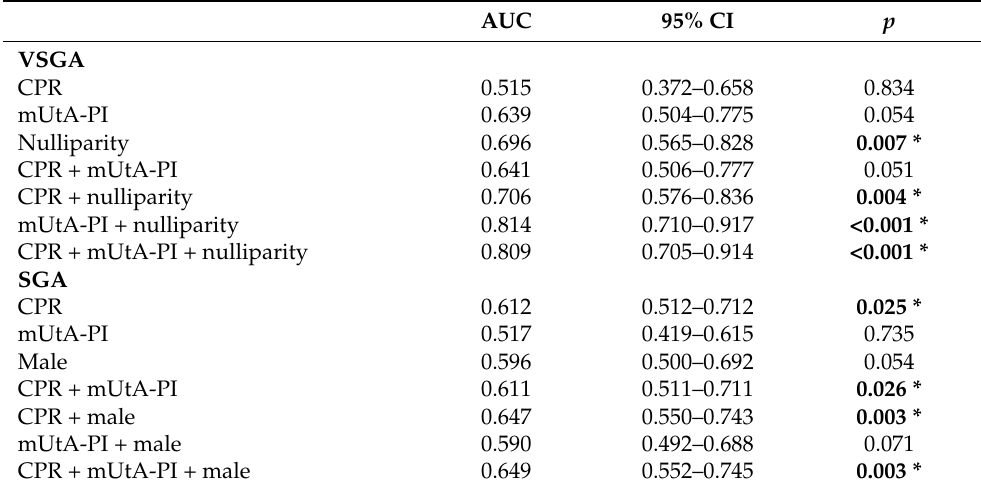
Table 4. Receiver operating characteristics analysis of Doppler parameters alone and combined to predict composite adverse perinatal outcome stratified by